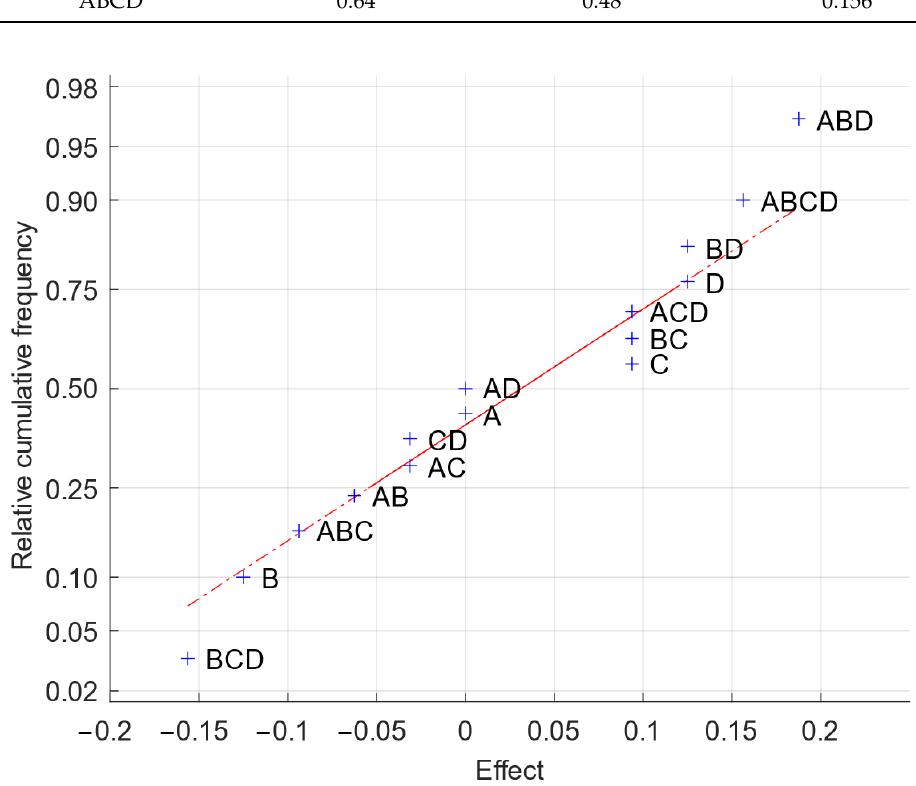
Figure 5. Calculated effects in Half Normal Probability Plot. The random scatter of the effects is estimated to check the significance of individual effects. To do this, the effects lying on the straight line (A, C, AD, BC, ABD and BCD) are pooled and the variance s 2 which results from the number of random effects ( f ) and the d effects are calculated according to Equation (2) [16]. 1 = · ∑ ( e f f ects ) 2 (2) s 2 d f random ef fects With a resulting s of 0.0943 and Student’s t-distribution, confidence intervals for d 95, 99 and 99.9% for two-sided confidence intervals can be determined. The effects of the factors and their interactions are shown in Figure 6. All effects are within the 95% confidence interval. Thus, no effect is considered statistically significant. The study